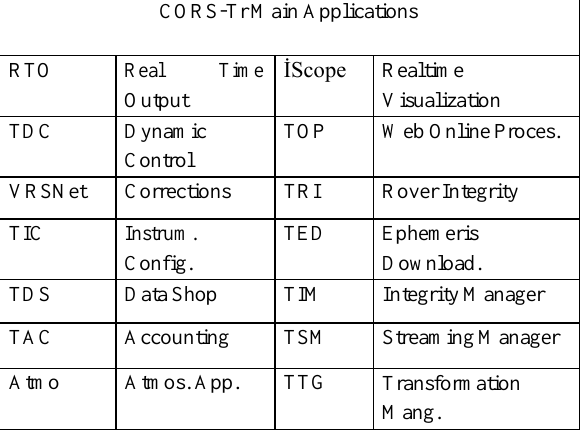
Figure 1.b: TUSAGA-Aktif applications